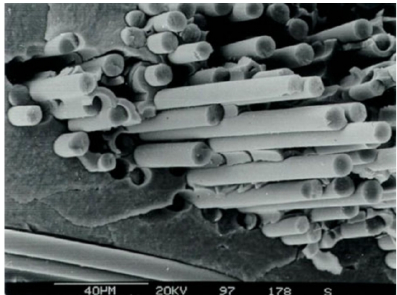
Figure 11. Microstructure of a CVI SiC/SiC composite. Reprinted from WikimediaCommons. Credit c (cid:13) MT Aerospace AG,